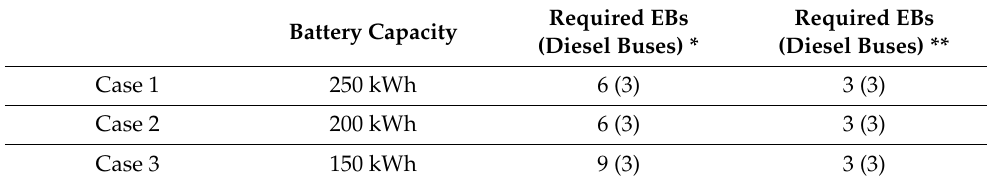
Table 1. Charging system sizing against EBs